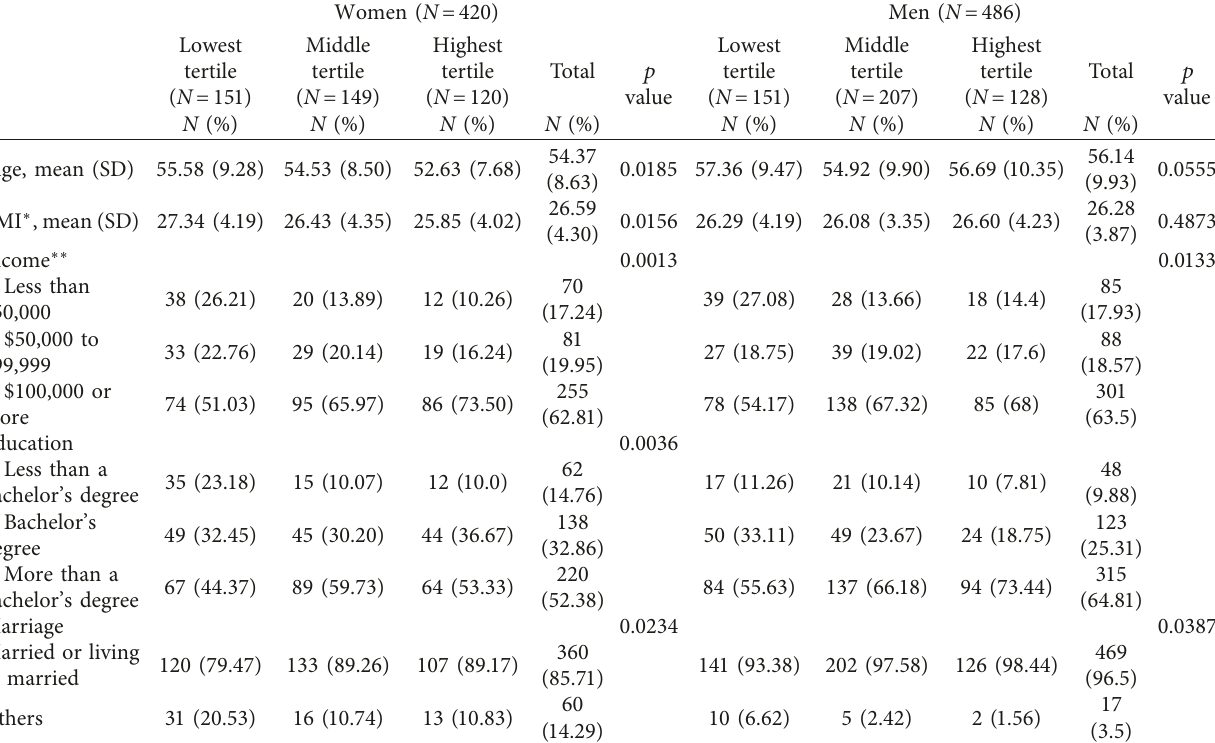
∗ Missing for 3 participants (one woman and two men). ∗ Missing for 26 participants (14 women and 12 men). ∗∗ P > 0 .